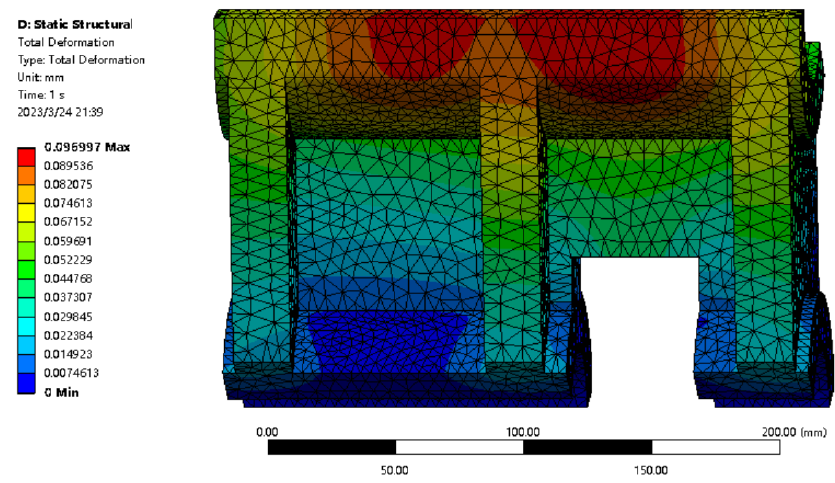
Figure 14. Deformation of lightweight drive rod.